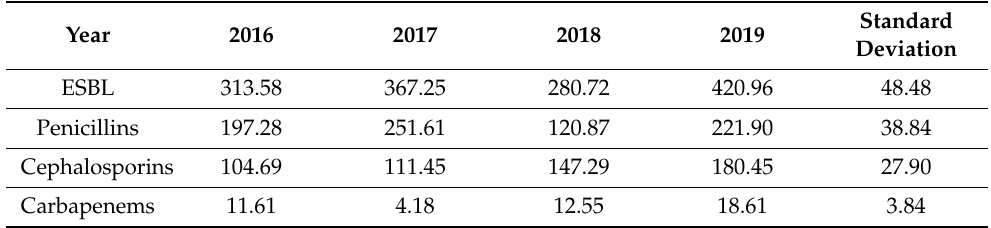
Figure 2. Seasonal variation of antibiotic resistance AMR in Ar-razi Hospital effluent. When a hospital is involved, as in our situation, the Defined Daily Dosage per 1000 beds (DDD/1000 beds) or per 1000 inhabitants (DDD/1000 inhabitants) is typically used to calculate drug consumption. The consumption of the most popular antibiotic families in ArzH from 2016 to 2019 is shown in Table 2. Table 2. Consumption of the main families of antibiotics expressed in Defined Daily Dose per 1000 beds (DDD/1000 beds) in ArzH between 2016 and